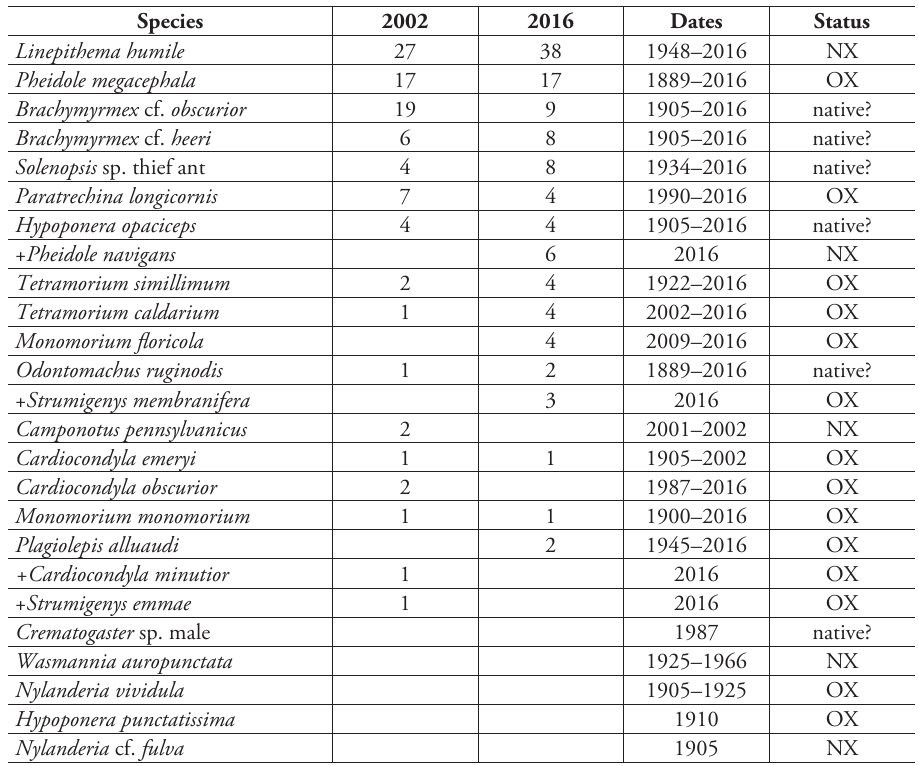
Table 1. Ants of Bermuda, arranged in descending order of the number of collection sites in 2002 (Wet- terer and Wetterer 2004) plus the number of collection sites in 2016. + = recorded for the first time in 2016. NX = New World exotic. OX = Old World exotic.